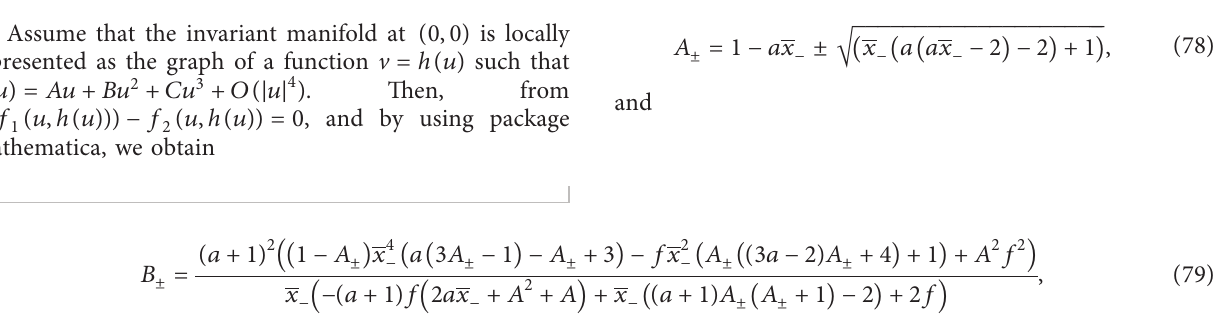
0.0 Figure 3: (a) Trajectory (black) of a solution of equation (1) and invariant curve (orange) for a � 0 . 49 and f � 0 . 125 and where a (b) Trajectory (black) of a solution of equation (1) for a � 0 . 51 and f � 0 . 125 and where a